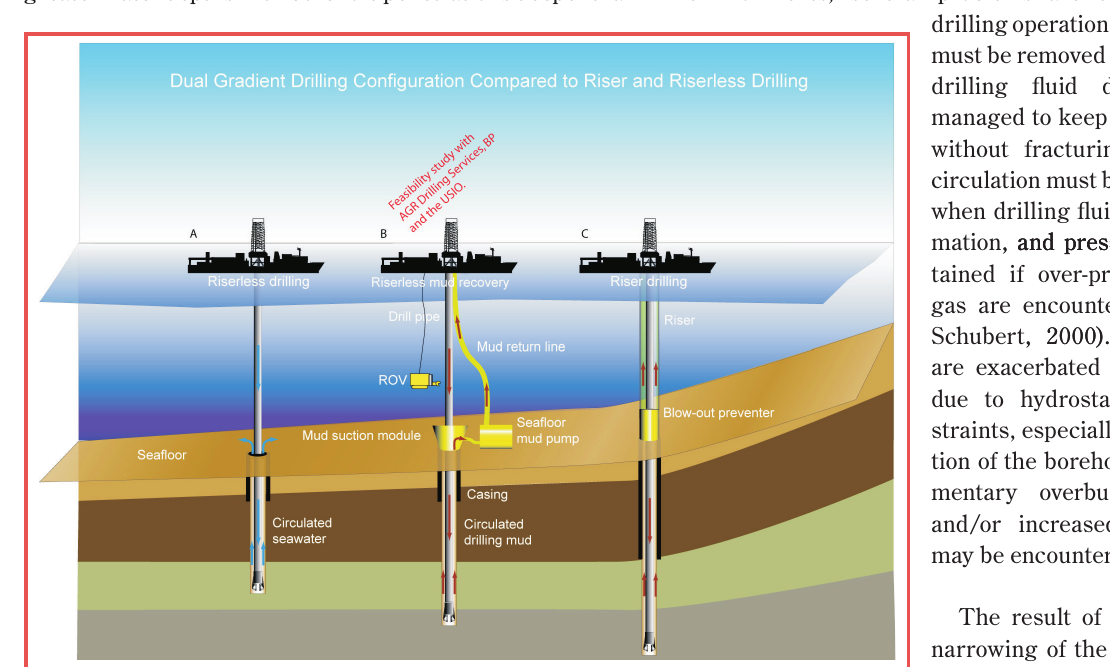
Figure 1. Dual gradient drilling (DGD) equipment may provide the technology needed to drill deep holes in deepwater. Riser drilling will still yield the deepest holes and riserless drilling will provide access to the deepest waters. Riserless [A] and riser [C] drilling configurations are depicted with a version of dual gradient drilling equipment provided by AGR Drilling services, named Riserless Mud Recovery (RMR) system